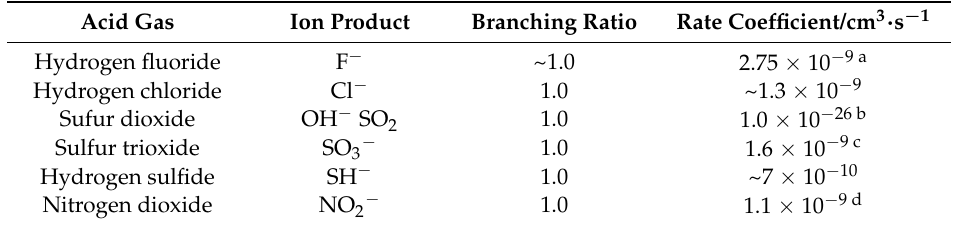
Table 5. OH − reactions of acid gases, nitrogen carrier gas, and flow tube at 120 ◦ C.